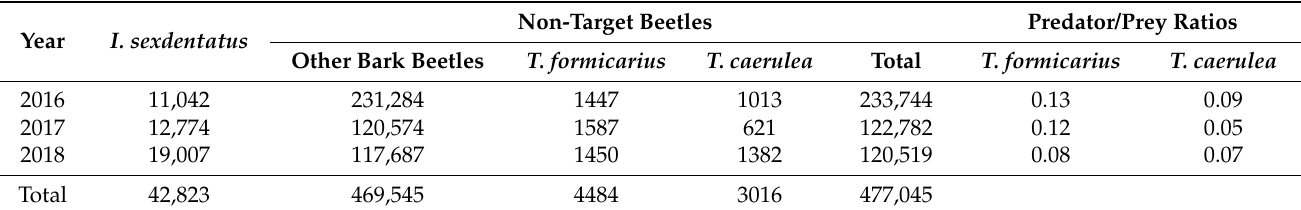
Table 1. Total number of beetles trapped with the Ips sexdentatus aggregation pheromone during the 2016–2018 period in the study site (Municipality of Grosseto, Tuscany, Italy).